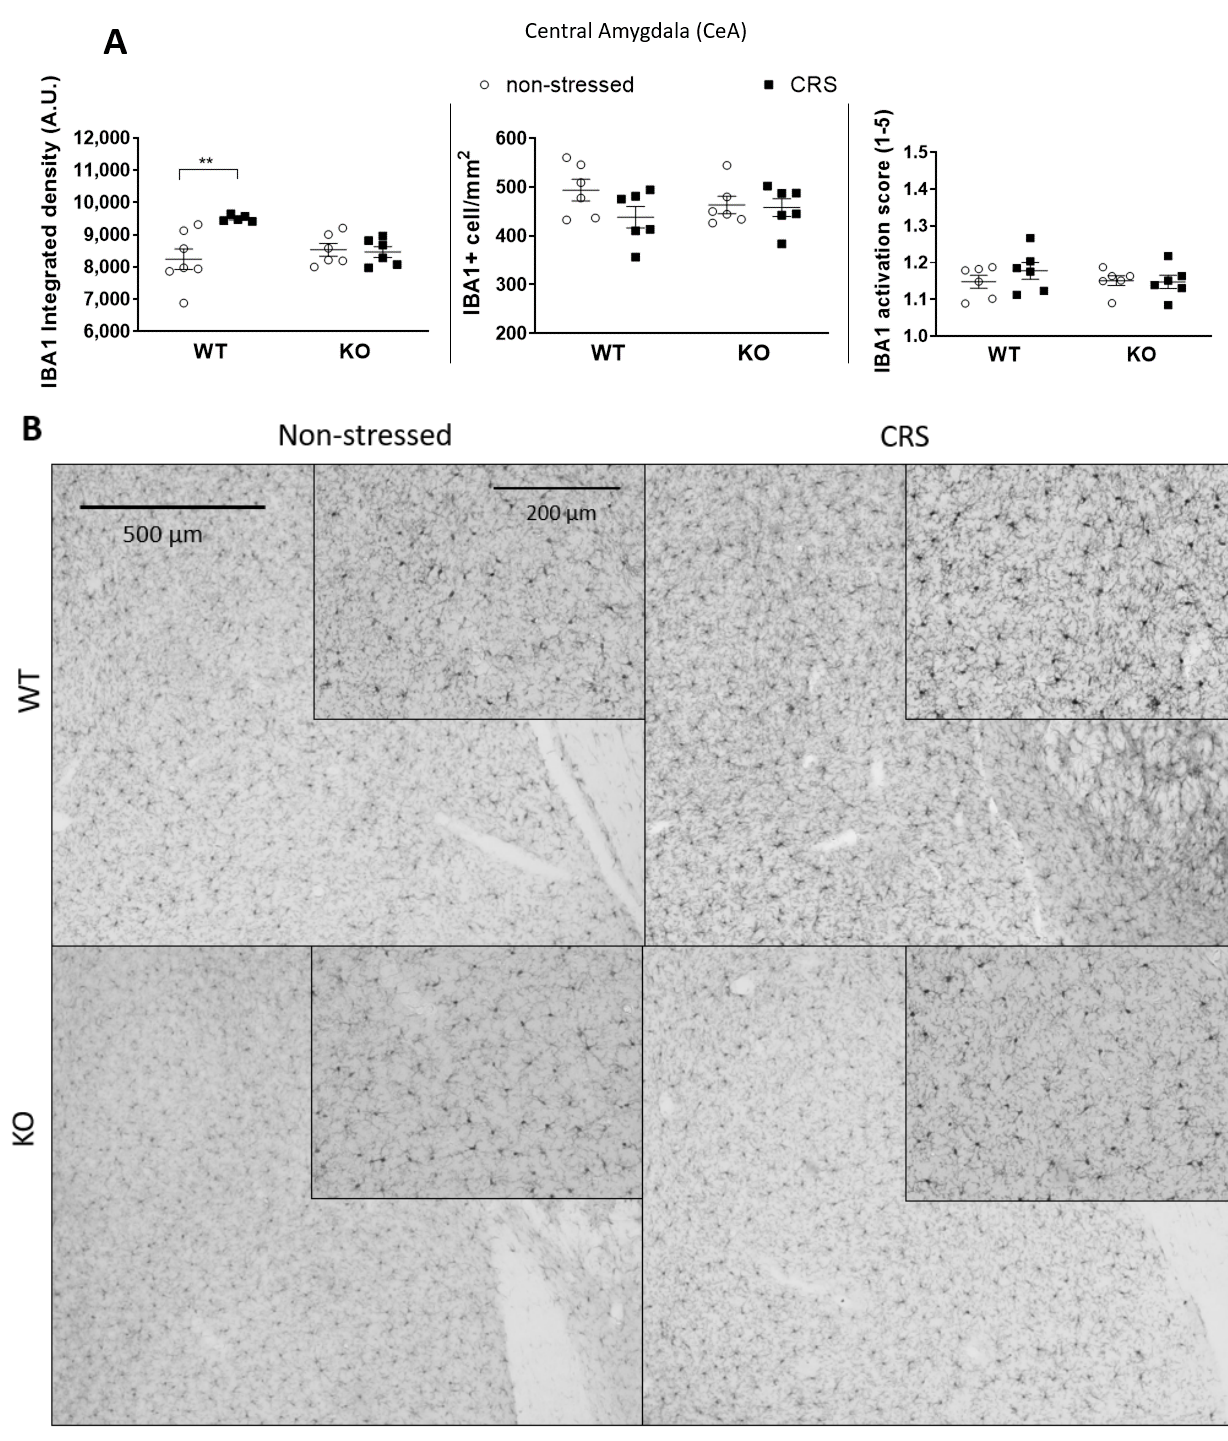
Figure 9. Diagrams show the Ionized calcium-binding adaptor molecule 1 (IBA1) integrated density, the number of IBA1+ cells and the IBA1 activation score of microglia examined in the Central Amygdala (CeA—( A )). Representative images show the IBA1+ microglia cells in CeA ( B ). Chronic restraint stress (CRS), Wild-type (WT), Interleukine-1 knock-out (KO). Data are presented as the means ± SEM of n = 5–7 animals with individual plots; two-way analysis of variance (ANOVA), followed by Tukey’s tests; ** p < 0.01 vs. respective group.